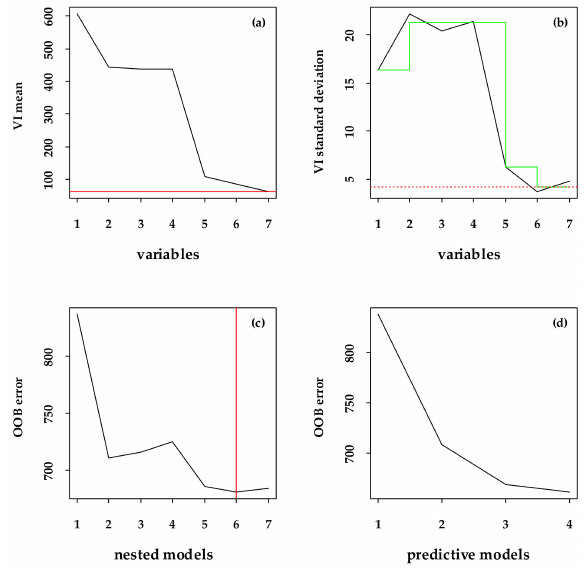
Figure 4. The variables selection of VBM. ( a , b ) Removes the negatively important variables based on the VI mean and standard deviation, respectively (( a ), the threshold position is represented by a solid red line that runs horizontally, and ( b ), the green segmented line represents the predicted value given by the CART model, and the red line with dashes running horizontally represents the minimum predicted value). ( c ) Gradually builds a random forest from only the most important variables to all variables selected in the first step, and selects the corresponding variables according to the average OOB error (the vertical solid red line indicates the minimum error position). ( d ) Gives the number of variables meeting the